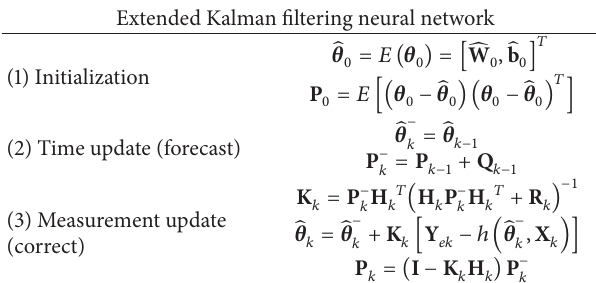
Table 1: Extended Kalman filtering neural network algorithm.